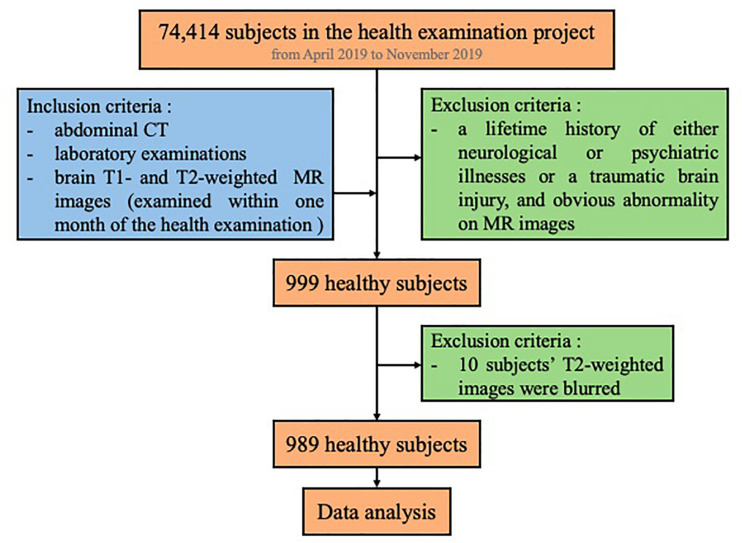
Subject screening workflow.